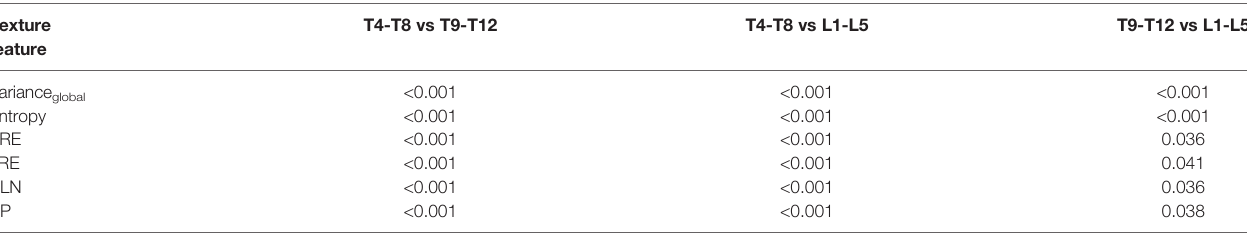
TABLE 9 | Pairwise signi fi cant differences of texture features between spine regions across all subjects. Texture